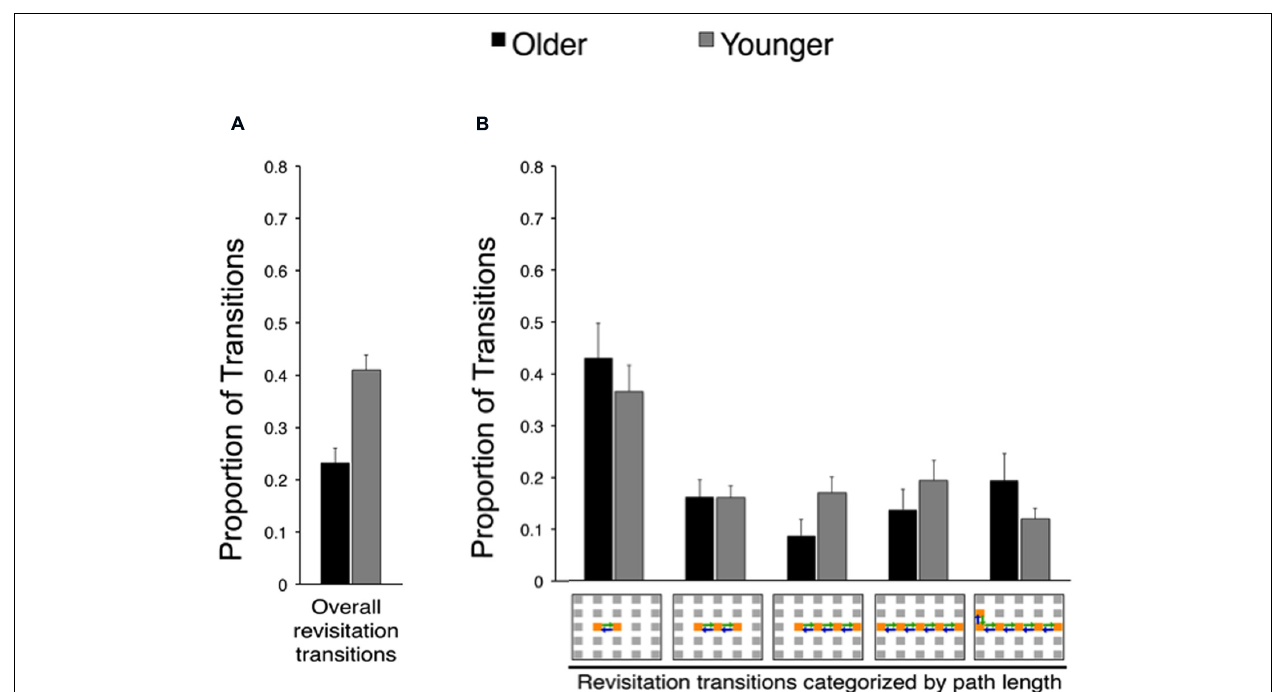
“path lengths” in each age group, irrespective of overall differences in the amount of revisitation (i.e., the overall amount is given in Panel A, and Panel B shows the proportion of the total involved in each path length separately for each age group). Back-and-forth transitions are shown as arrows on the grid. Error bars depict standard error.